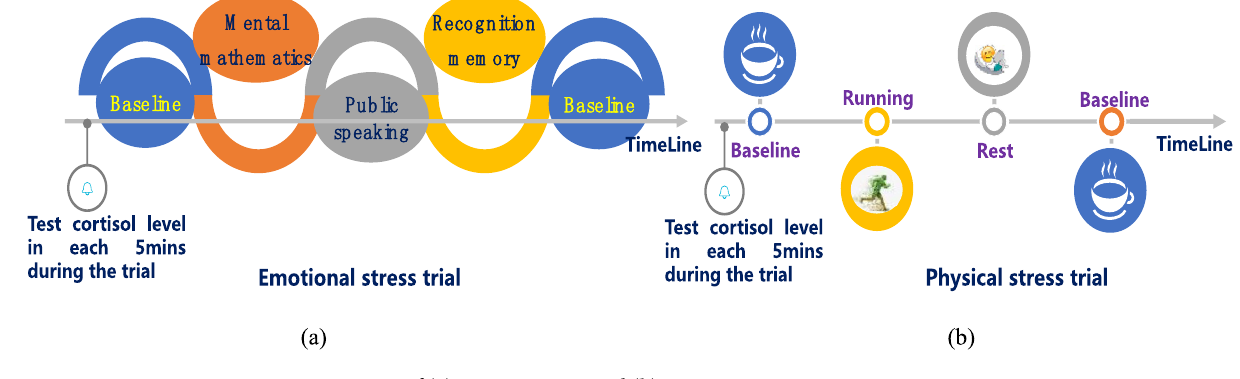
Figure 1. Process of ( a ) ES experiment and ( b ) PS